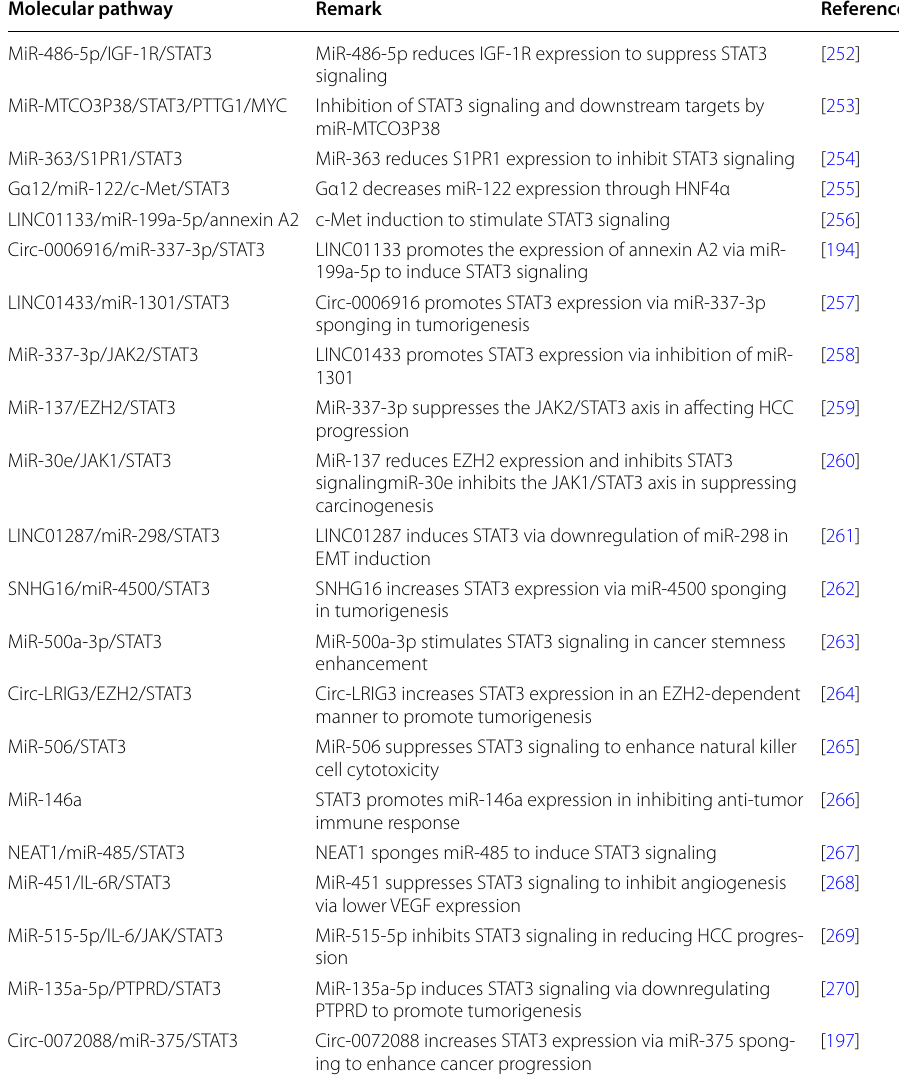
Table 4 The role of noncoding RNAs in the regulation of STAT3 signaling in HCC Molecular